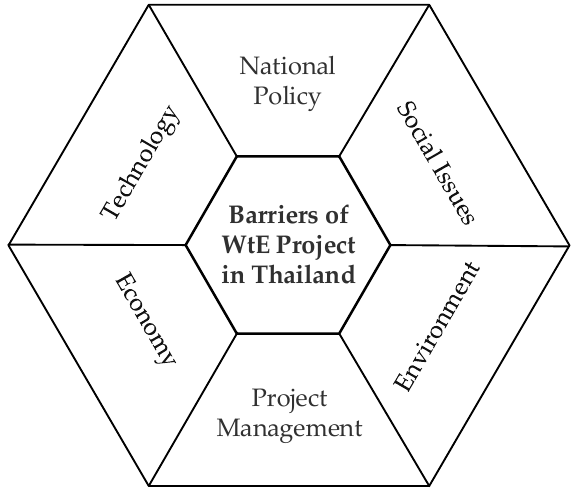
Figure 5. The six sections barriers classified. Table 1. Sources of barriers of this study.